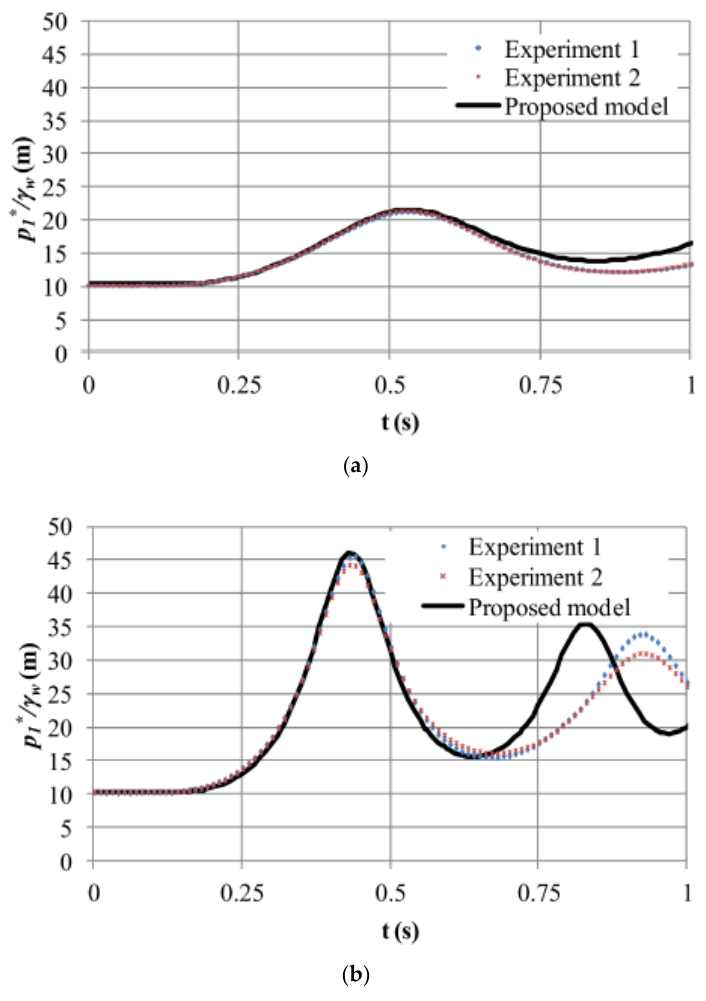
Figure 1. Air pocket pressure patterns: for initial air pocket sizes (x0) 1.36 m, and initial gauge pressures (p0) of 0.50 ( a ) and 1.25 ( b ) bar in the hydro-pneumatic tank during a filling process.